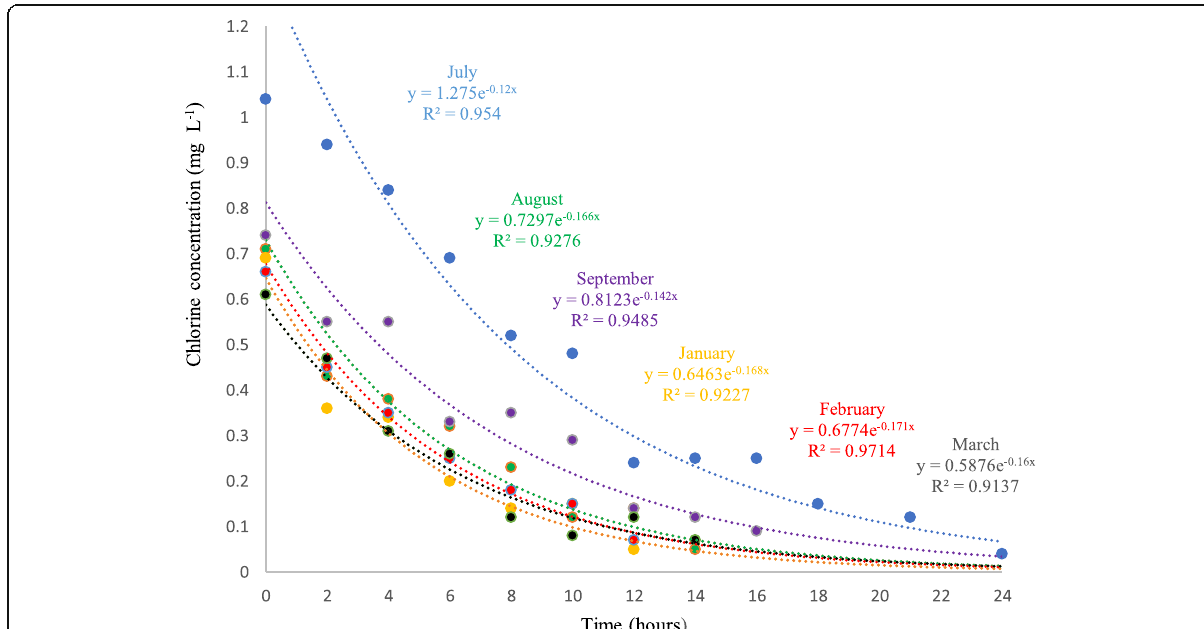
Fig. 2 Chlorine decomposition coefficients in mass at different initial chlorine concentrations. An exponential relationship was obtained between the chlorine concentration (C) and the elapsed time (t) in each sample collected during the 6